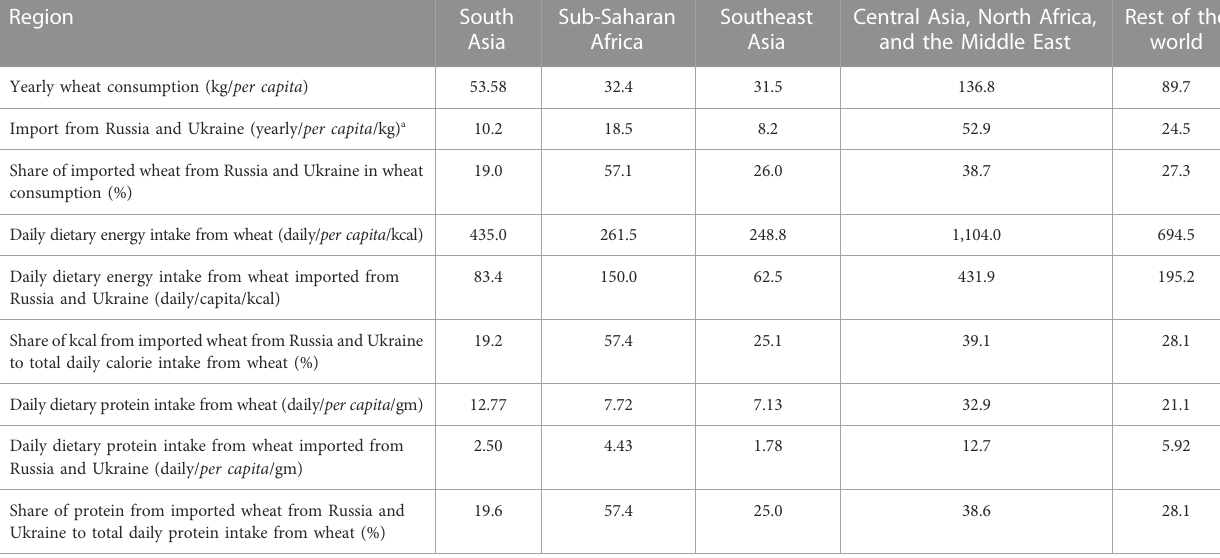
TABLE 6 Importance of imported wheat from Russia and Ukraine in food and nutrition security of the sampled regions. Region